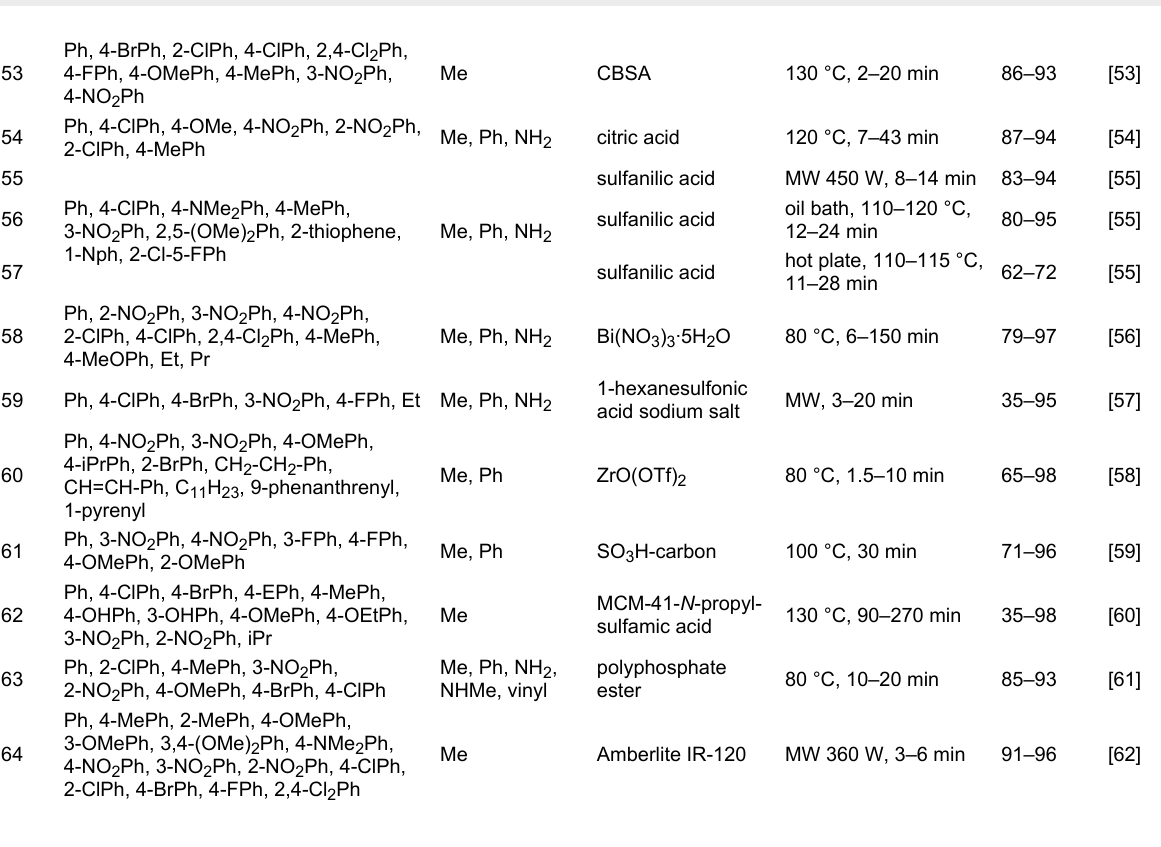
Table 1: Comparison of various conditions applied in the synthesis of amidoalkylnaphthols 4 .